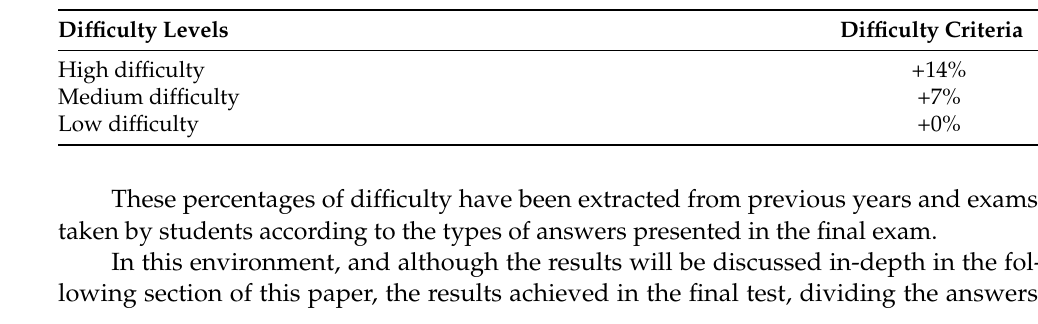
Table 6. Rating of